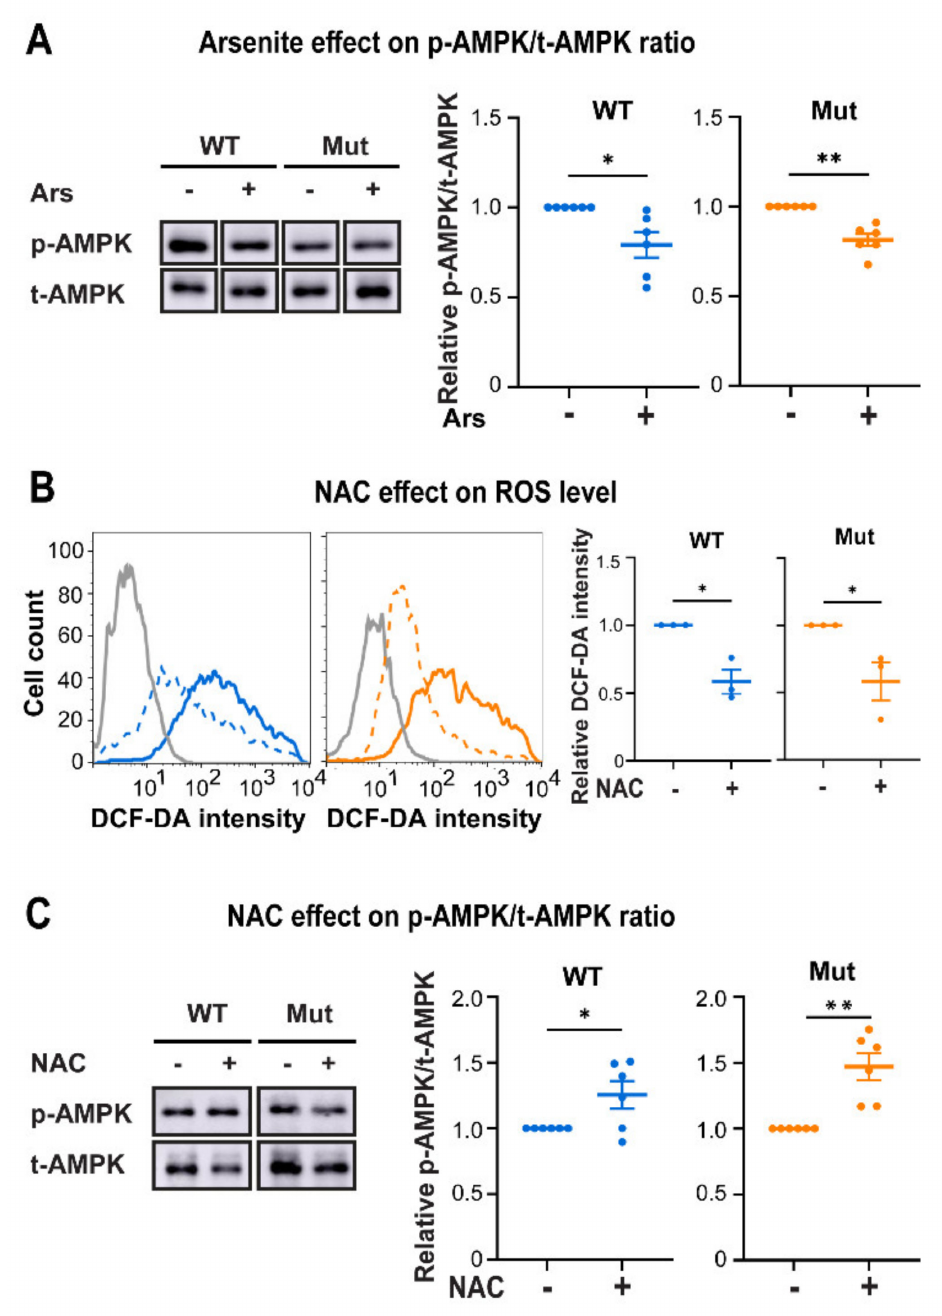
Figure 5. Effect of Ars and NAC on ROS level and AMPK activity in WT (blue) and Mut (orange) primary astrocytes. Cells were cultured for 48 h in DMEM-HG medium in the presence or absence of 20 µ M Ars for the last 24 h ( A ) or in the presence or absence of 4 mM N-Acetyl-Cysteine (NAC) for 48 h ( B , C ) followed by immunoblot analyses using antibodies specific for p-AMPK and t-AMPK. Representative blots are shown; data represent average ± SEM of p-AMPK/t-AMPK ratio relative to untreated samples ( A , C ). Flow cytometry analysis after DCF-DA staining is shown in B. Grey, unstained; Blue, WT; Orange, Mut (continuous lines, untreated; dotted lines, NAC-treated). Graph presents the average ± SEM of mean DCF-DA fluorescence intensity relative to untreated cells. Statistical analysis is detailed in Materials and Methods. * p ≤ 0.05, ** p ≤